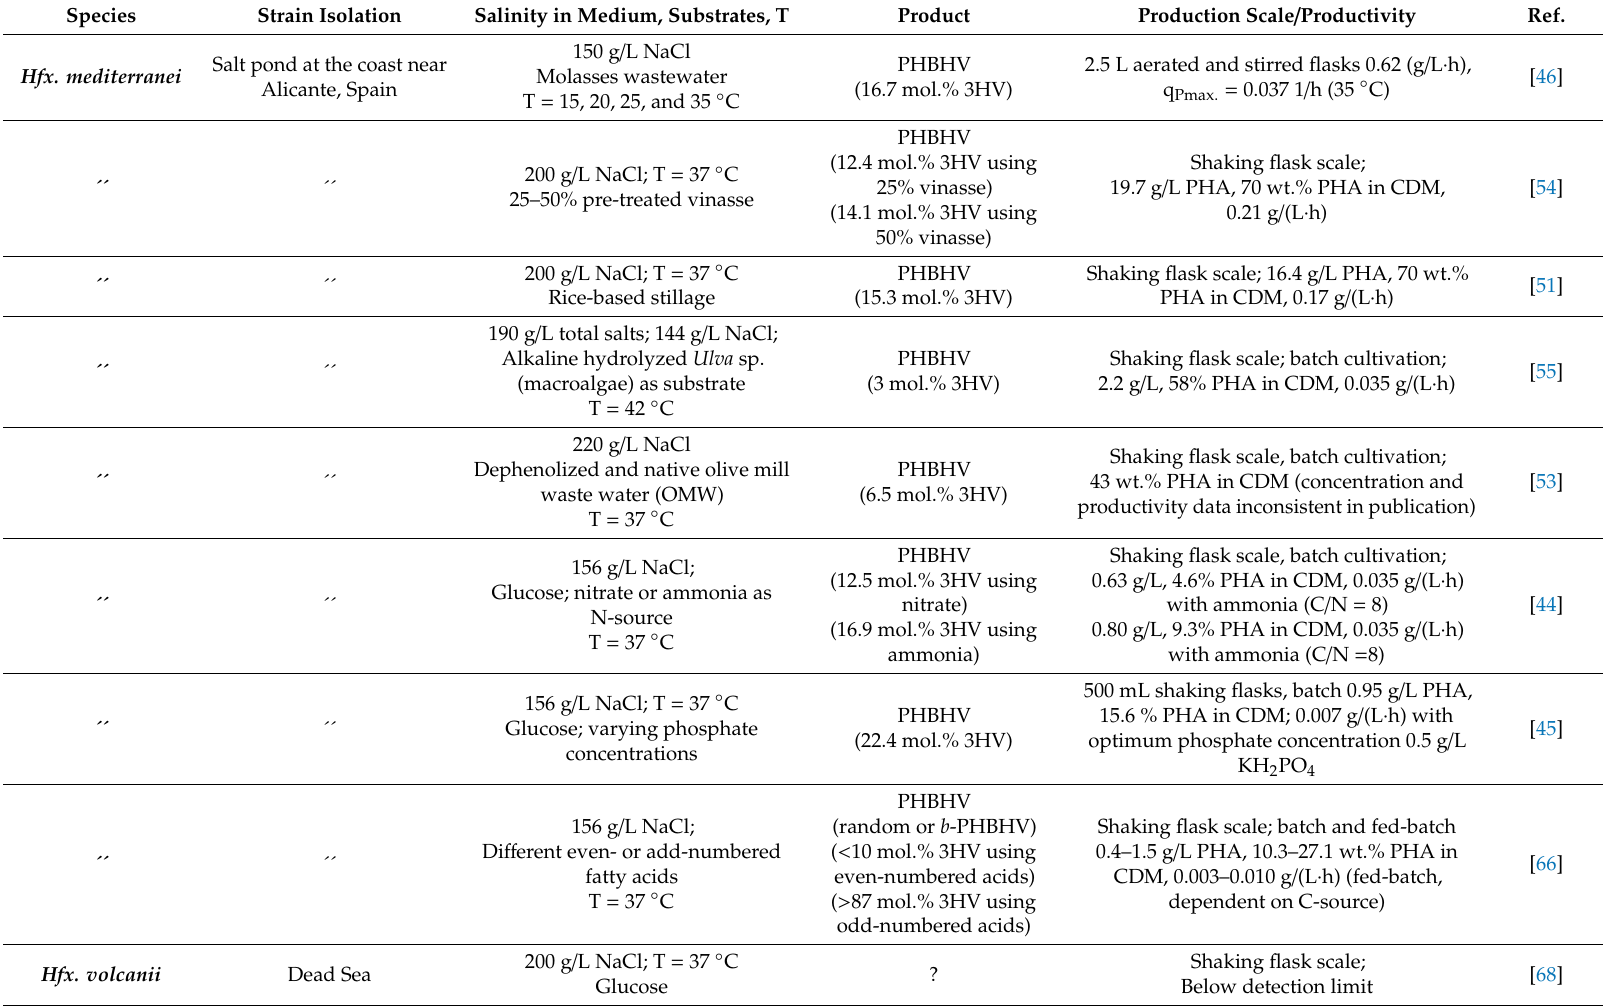
Table 1. PHA production by haloarchaea on shaking flask and stirred flask scale–collected data from